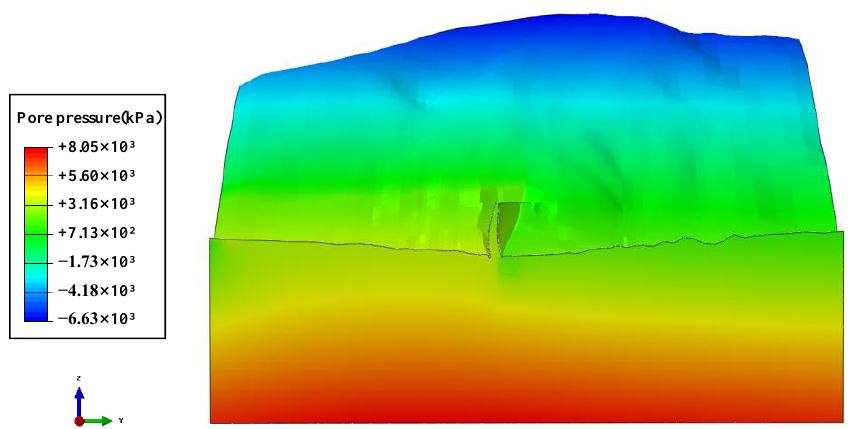
Figure 18. Numerical calculation results of riverbed cross-sectional pore pressure.